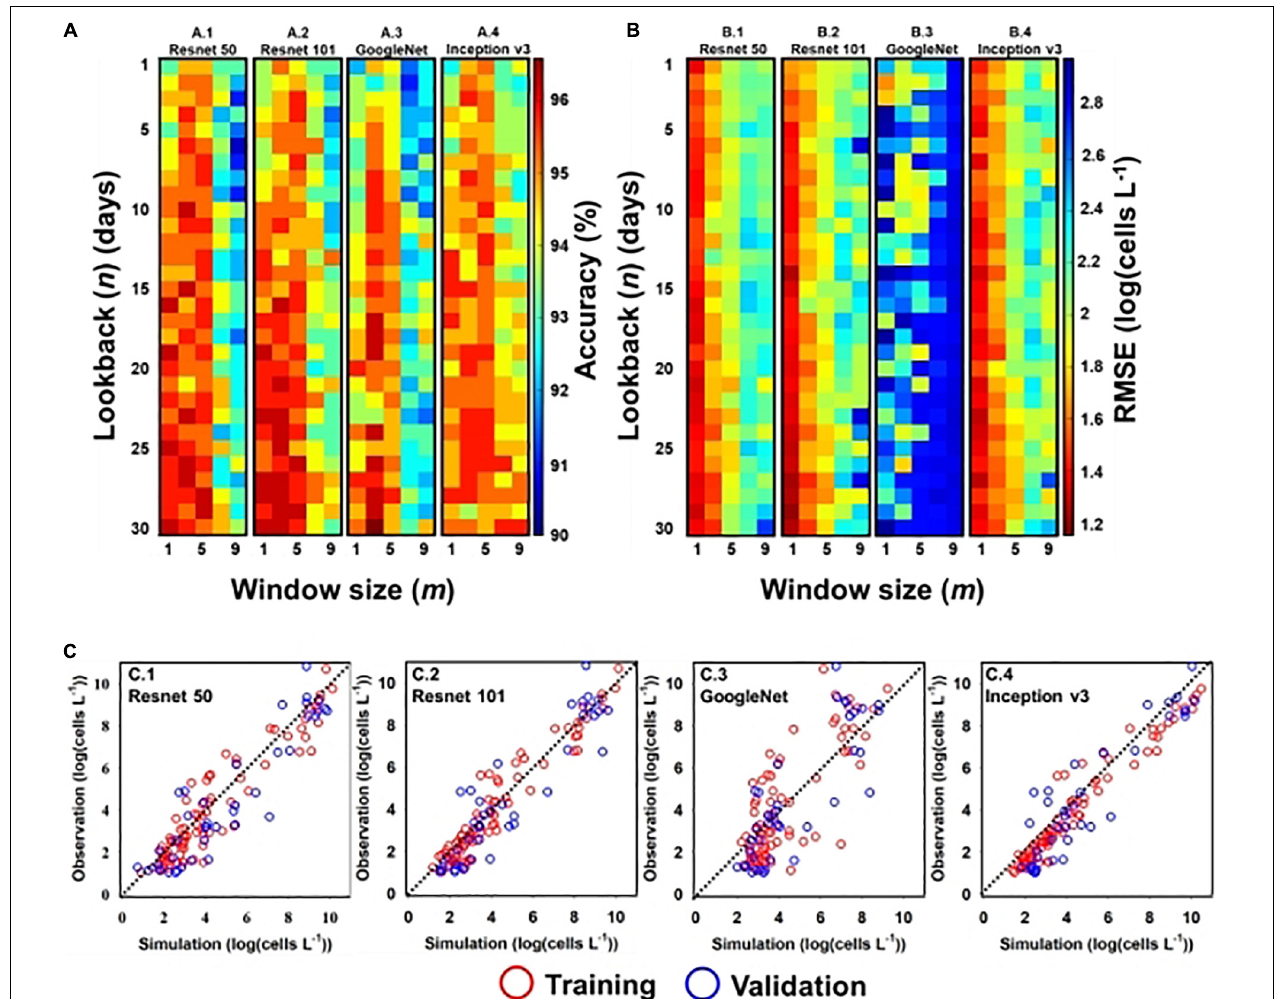
FIGURE 4 | Optimal input and simulation results of A. catenella — (A) optimal input ( m and n ) of classification CNN structures: (A.1) Resnet 50, (A.2) Resnet 101, (A.3) GoogleNet, and (A.4) Inception v3; (B) optimal input ( m and n ) of regression CNN structures: (B.1) Resnet 50, (B.2) Resnet 101, (B.3) GoogleNet, and (B.4) Inception v3; (C) simulated and observed densities of A. catenella with regression CNN structures [e.g., (C.1) Resnet 50, (C.2) Resnet 101, (C.3) GoogleNet, and (C.4) Inception v3] with optimal input. In (A) and (B) , m and n denote the input window (i.e., height × width) and lookback sizes, respectively, whereas the color range indicates the accuracy from the lowest (blue) to the highest (red) values. In (C) , the red and blue circles indicate the training and validation sets, respectively. The observed line has a slope of